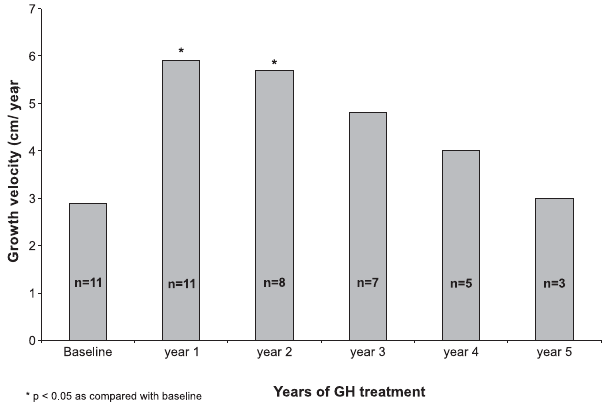
Figure 1 - Mean GV increase in TS girls after rhGH compared to initial GV